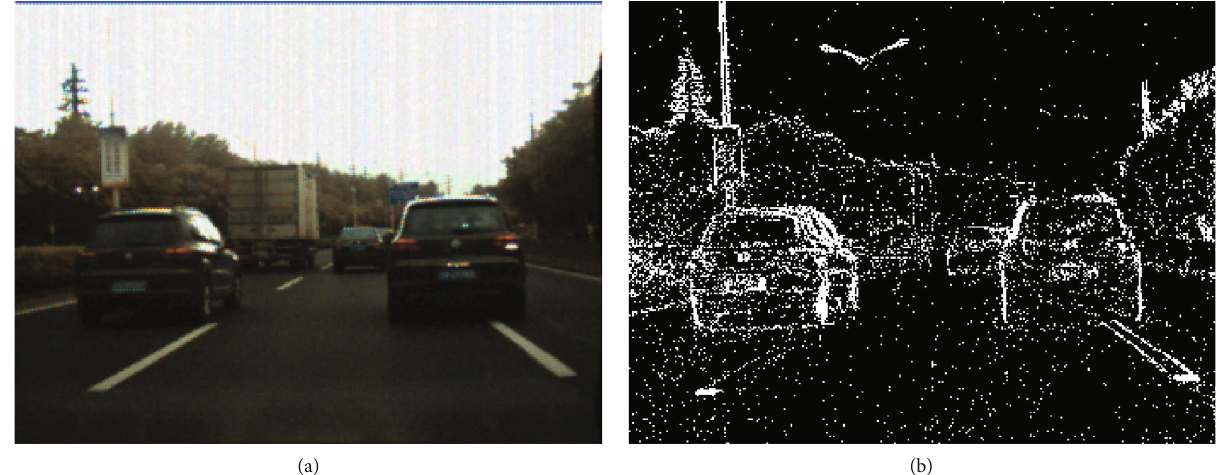
Figure 3: DAVIS camera output. (a) APS frame. (b) Accumulated event frame.